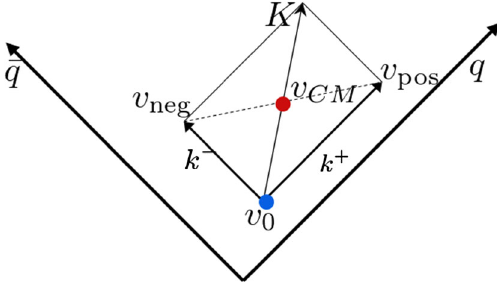
Fig. 32 Final region of a q ¯ q system. The origin of the region is repre- sented by v 0 while v CM stands for the location of the CM of the region. The four-momentum of the final region is defined as K . As in other cases, v pos and v neg represent the old